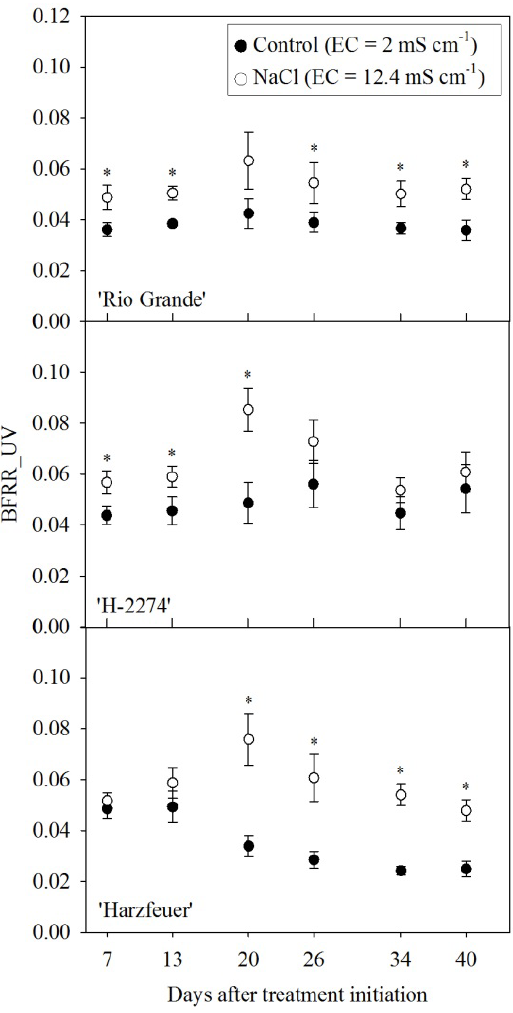
Figure 2. Blue-to-far-red fluorescence ratio (BFRR_UV) after excitation with UV light displayed over the time course of the experiment. Readings were taken on tomato leaves from the genotypes Rio Grande, H-2274 and Harzfeuer. Values represent the mean ± SE (standard error, n = 10). * Significant differences ( p ≤ 0.05) between control and NaCl treatment for each genotype and measuring day, assessed by t